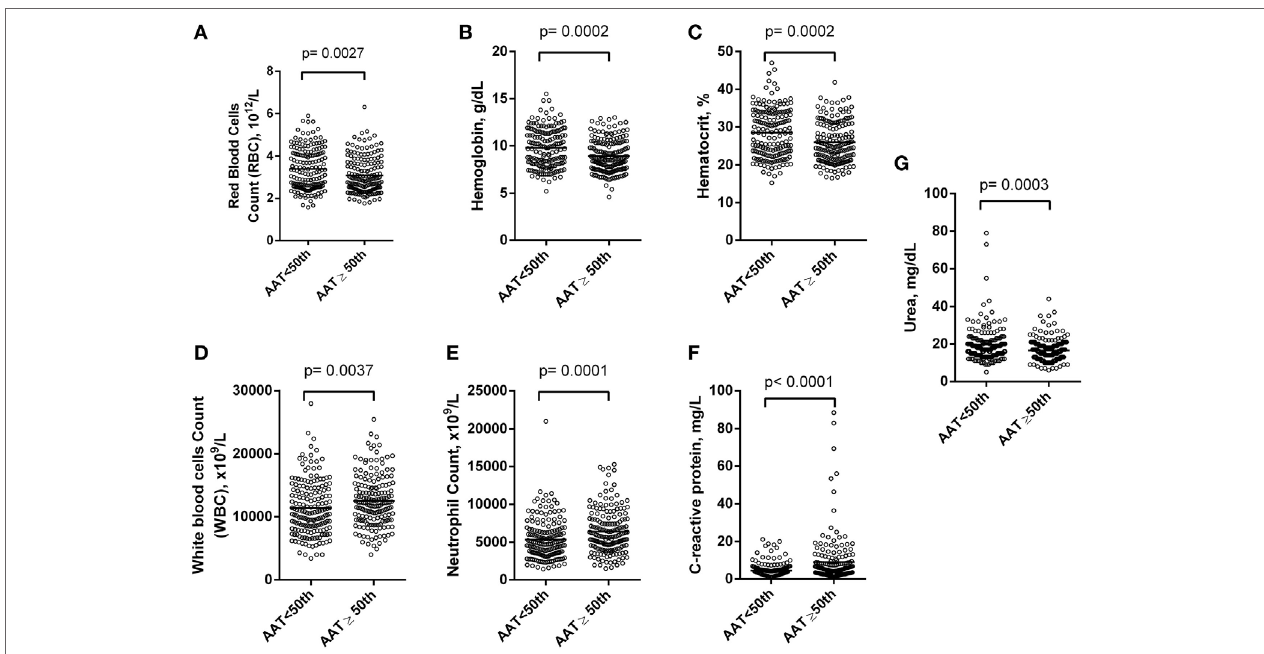
FigUre 5 | Association of hematological and chemistry markers in steady-state sickle cell disease (SCD) patients with alpha-1 antitrypsin (AAT) concentrations higher and lower than the 50th percentile. Statistical analyses indicate that SCD patients with alpha-1 antitrypsin concentration higher than the 50th percentile (158.0 mg/mL) had (a) lower count of red blood cells (RBCs); (b) lower concentration of hemoglobin (Hb); (c) lower concentration of hematocrit (Hct); (D) higher count of white blood cell (WBC); (e) higher count of neutrophils; (F) higher concentration of C-reactive protein (CRP); (g) higher concentration of urea.